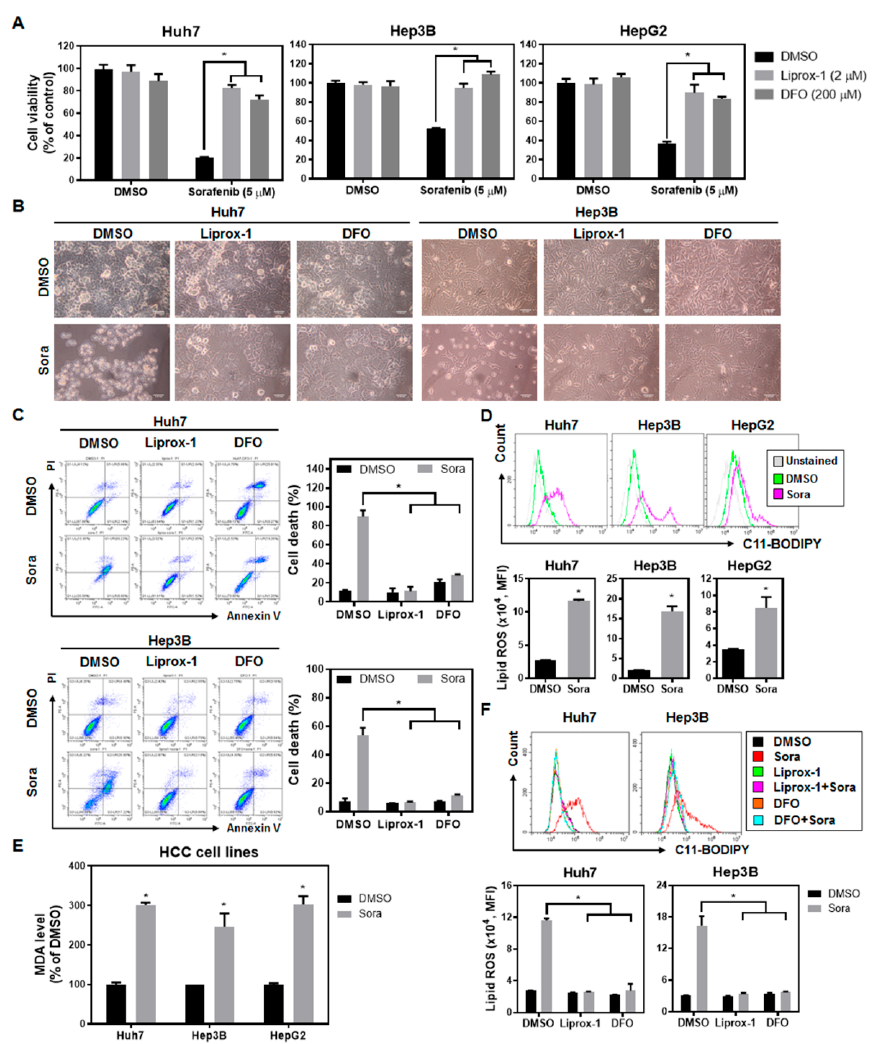
Figure 1. Sorafenib induces ferroptosis in hepatocellular carcinoma (HCC) cells: ( A ) Huh7, Hep3B, and HepG2 cells cultured in complete Dulbecco’s modified Eagle medium (DMEM) medium were treated with sorafenib with or without ferroptosis inhibitors (Liprox-1 and DFO) for 16 h, and cell viability was quantified by a 3-[4,5-dimethylthiazol-2-yl]-2,5-diphenyltetrazolium bromide (MTT) assay. ( B ) Images of cell morphology for HCC cells treated with dimethyl sulfoxide (DMSO) (0.3%) or sorafenib (5 µM), in the presence or absence of the indicated ferroptosis inhibitors, for 16 h. Scale bar = 100 µm. ( C ) Cell death (PI-positive population, %) evaluation was performed using an Annexin V/PI Assay Kit. After exposure to sorafenib with or without ferroptosis inhibitors for 16 h, cells were subjected to flow cytometry analyses. ( D ) The extent of lipid ROS accumulation was determined in three HCC cells lines treated with sorafenib (5 µ M) for 16 h using C11-BODIPY. ( E ) Sorafenib treatment significantly enhanced the amount of malondialdehyde (MDA) in HCC cells. Cells were treated with sorafenib (2.5 µ M for Huh7 and HepG2 cells; 5 µ M for Hep3B cells) for 16 h and then the level of lipid peroxidation was determined. ( F ) The use of the ferroptosis inhibitors Liprox-1 and DFO reduced lipid ROS levels in HCC cells treated with sorafenib. Columns: mean; bars: SD (n ≥ 3). Statistical significance was evaluated using the Mann–Whitney U test (*, p <